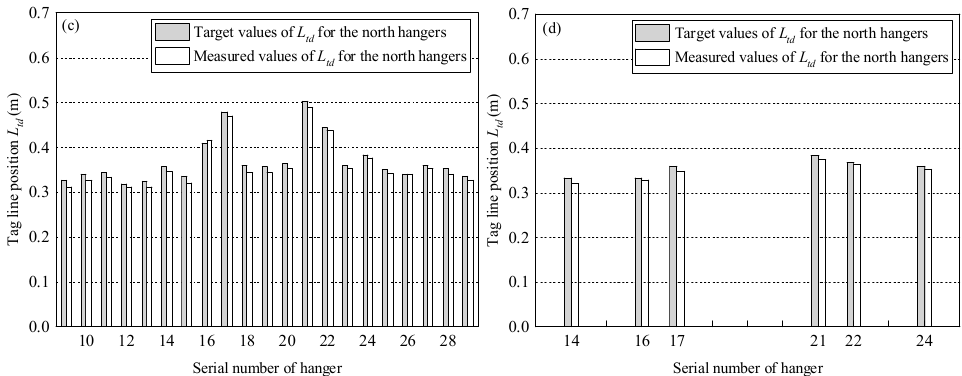
Figure 18. Comparisons of the tag line positions of north hangers. ( a ) Tensioning round 1. ( b ) Tensioning round 2. ( c ) Tensioning round 3. ( d ) Tensioning round 4.